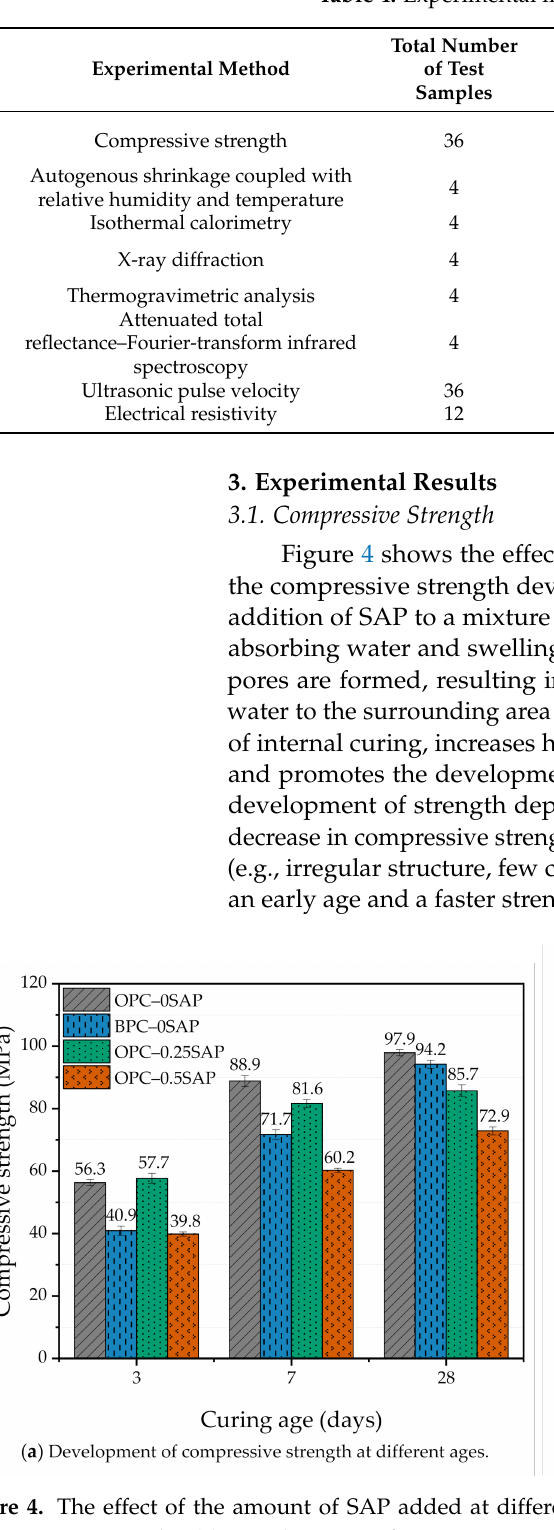
Table 4. Experimental methods and test ranges.